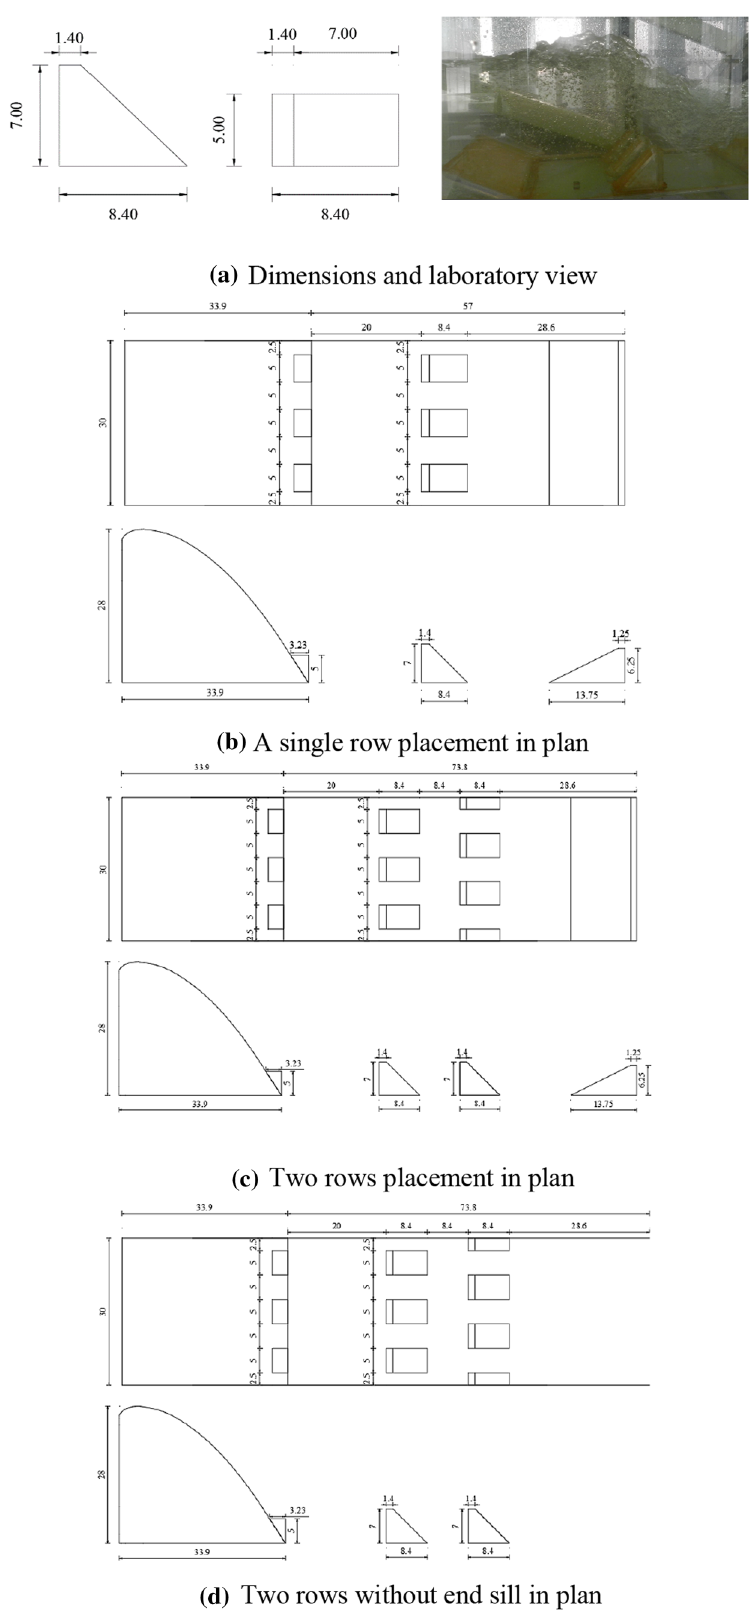
Fig. 7 Trapezoidal block types used in the experiments. a Dimensions and laboratory view. b A single row in plan. c Two rows in plan. d Two rows without end sill in